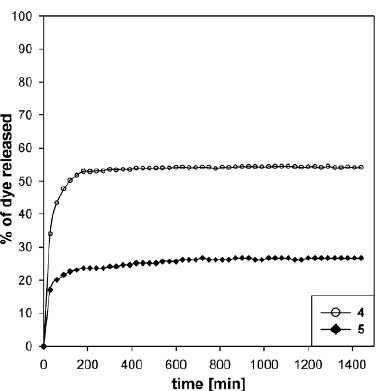
Figure 10. Release of 2 from modified MCM-41 silica at pH= 6.8.